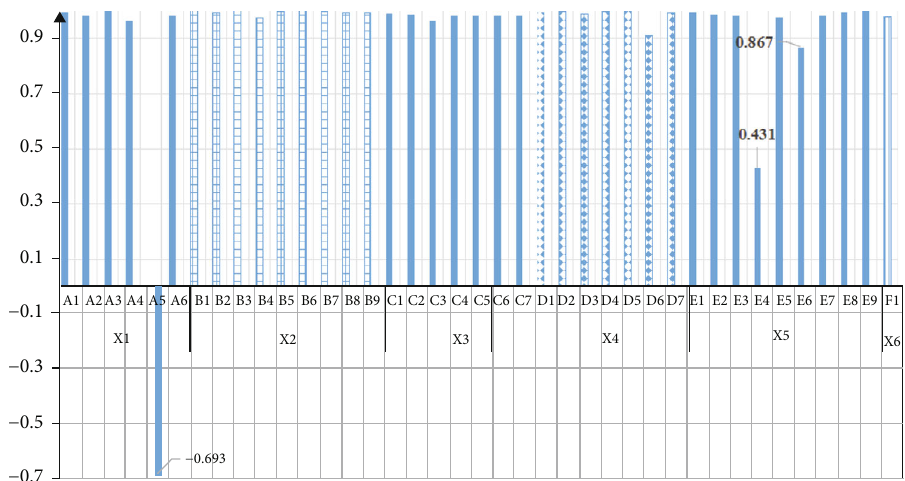
Figure 3: Correlation coe ffi cient analysis between tax and secondary